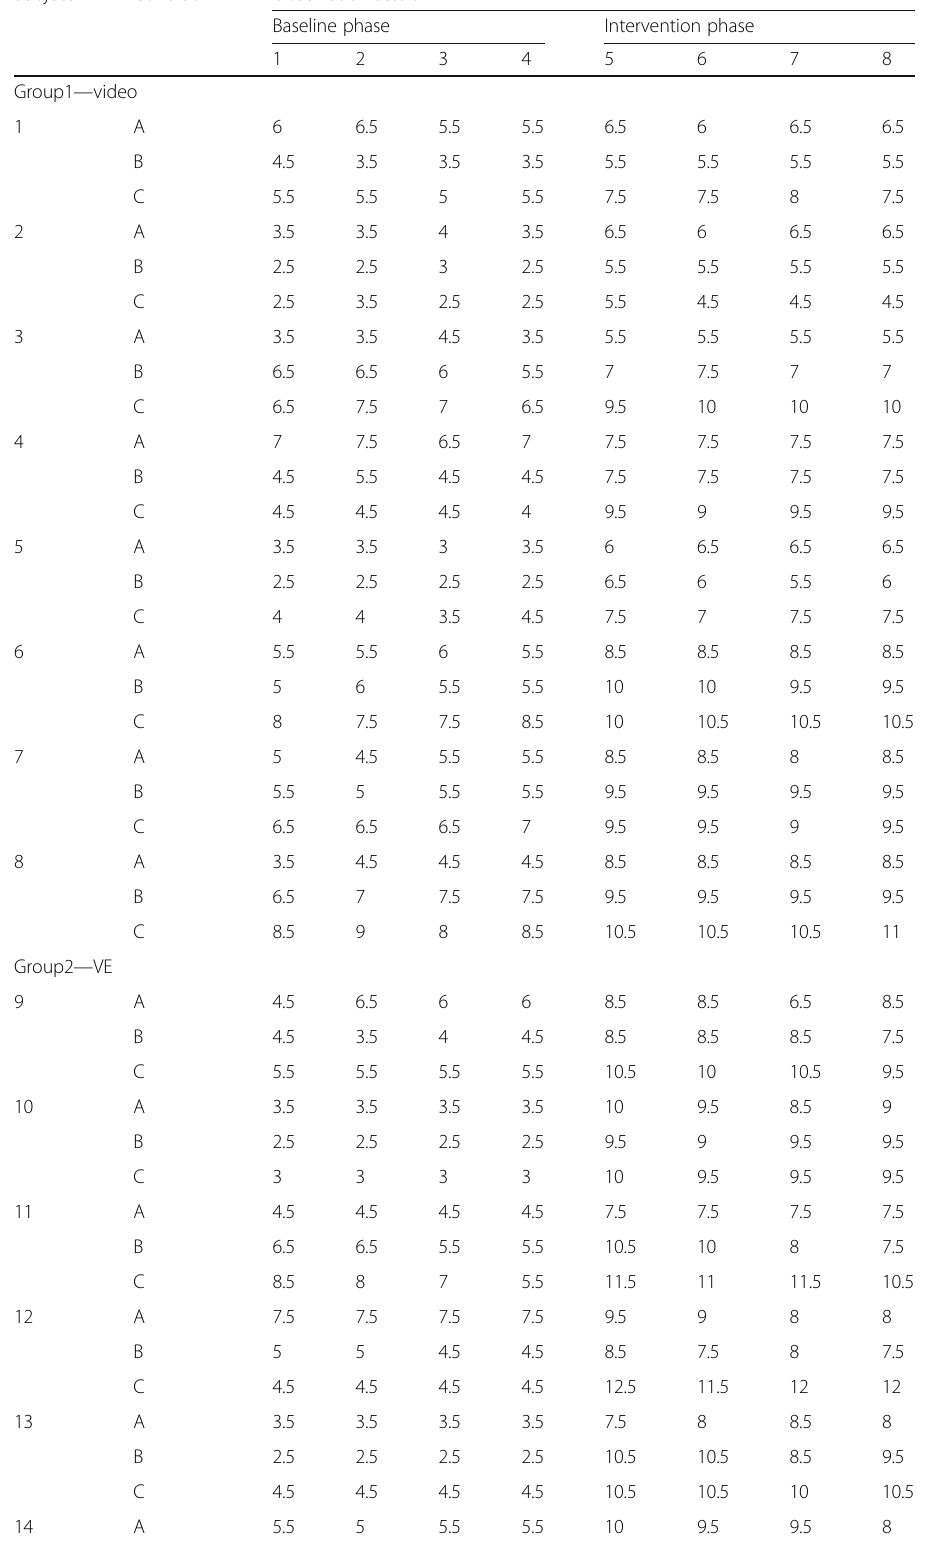
Table 4 The number of acceptable behaviors per observation session and per